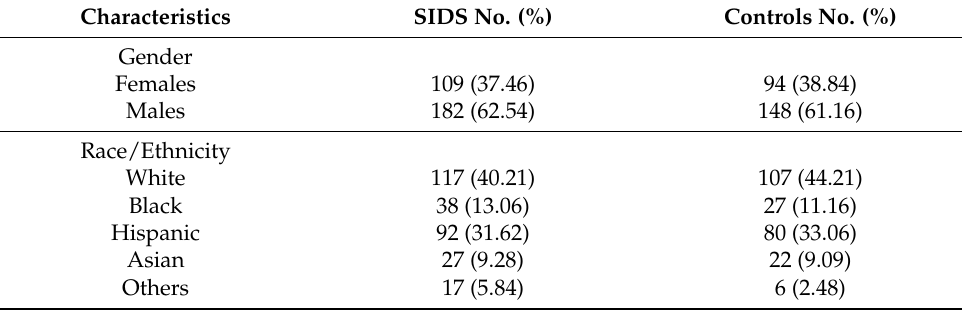
Table 2. Demographics.